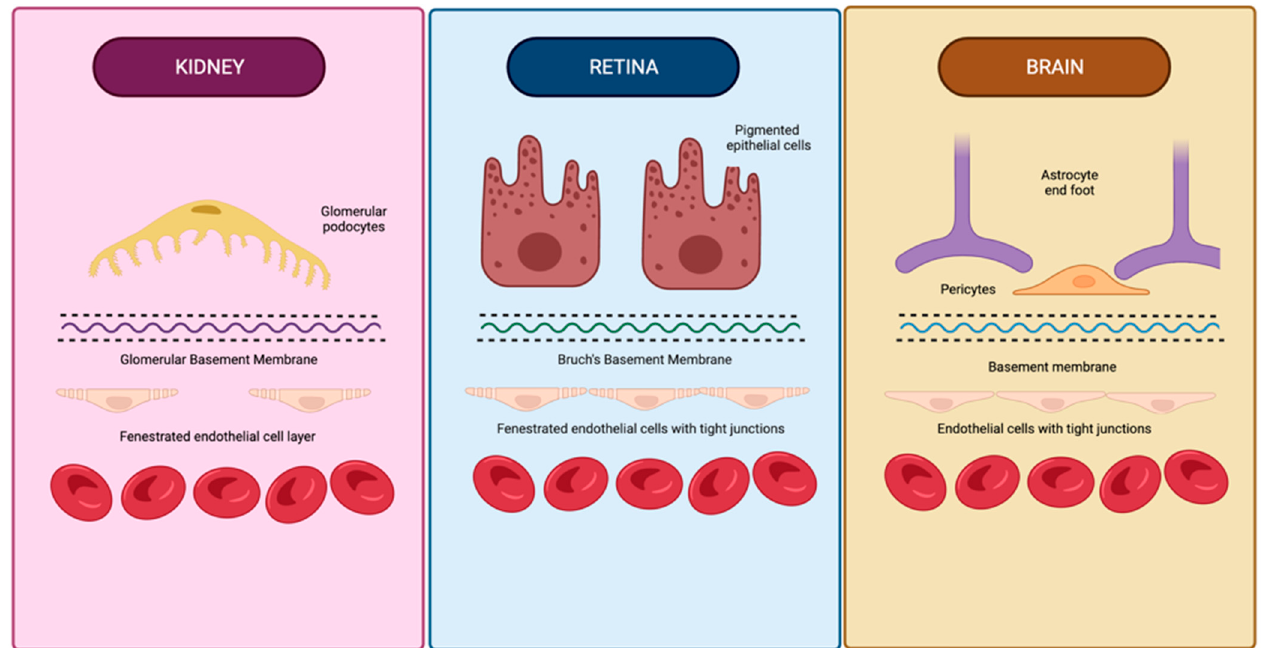
Figure 1. Similarities in anatomical structure of vascular barriers in the brain, retina, and kidneys. The vascular barriers of the brain, retina, and kidneys have many structural similarities, including basement membranes containing type IV collagen, an outer layer with analogous projections (glomerular podocyte foot processes, retinal epithelial cell projections, and astrocyte foot processes), and a fenestrated endothelial cell layer in the glomerulus and retina. Created using BioRender.com on 26 August 2022.